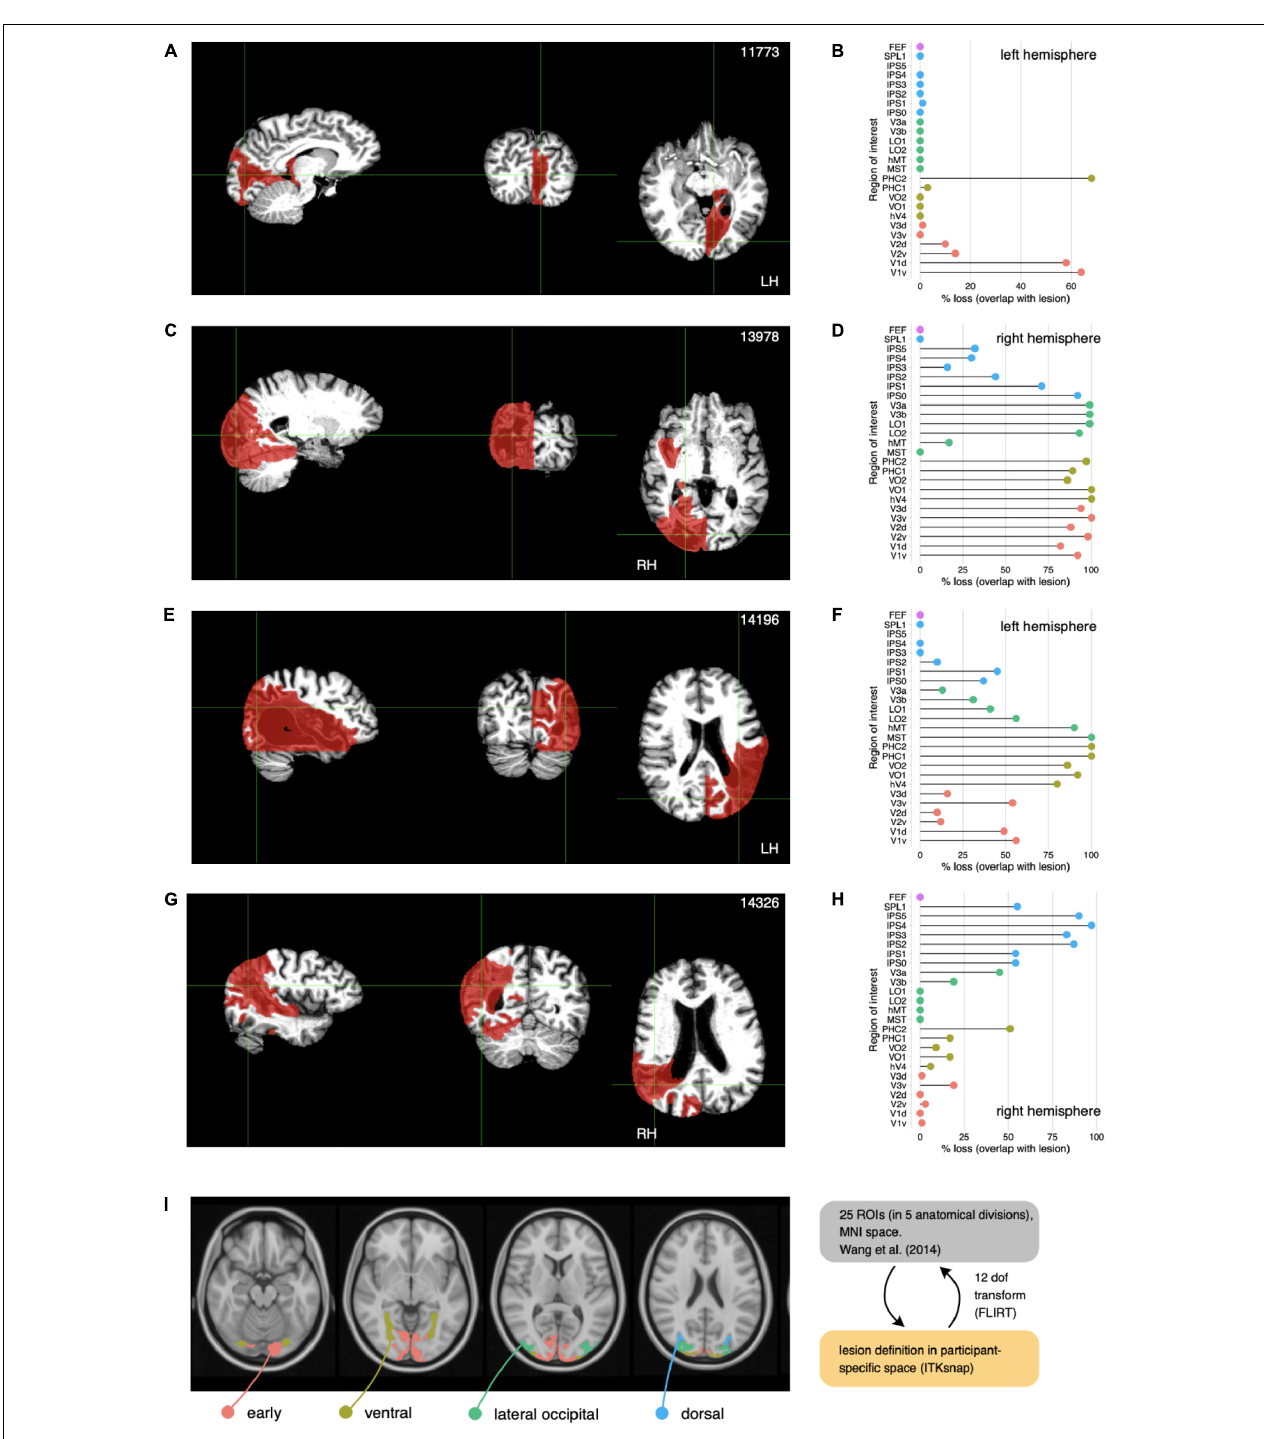
FIGURE 3 | Anatomical lesions. Locations and quantification for each participant. (A,C,E,G) Brain-extracted anatomical images in sagittal, coronal, and axial view (grayscale), in planes that show the extent of the anatomically defined lesions (red). We used optiBET (Lutkenhoff et al., 2014) for skull stripping. (B,D,F,H) Lesion damage by subregions. To quantify lesions with respect to known visual areas, we transformed the lesion masks in participant space into MNI space and computed percentage overlap with the regions of interest defined in the probabilistic atlas of Wang et al. (2015). Each row (dot) in the dotplot shows percentage loss for an ROI (V1 bottom, to FEF, top). To aid visualization, we grouped ROIs into cortical territories: early visual (red), ventral (dark yellow), lateral occipital (green), dorsal (blue), see also Figure 5 . (I) Location of cortical ROIs from Wang et al. (2015) atlas. The location of the four cortical territories (colors) comprising 25 ROIs are shown on axial slices of the MNI152 brain (gray). Note that the Wang et al. (2015) atlas also included labels for frontal eyefiels (FEF), but none of the participants showed damage in that